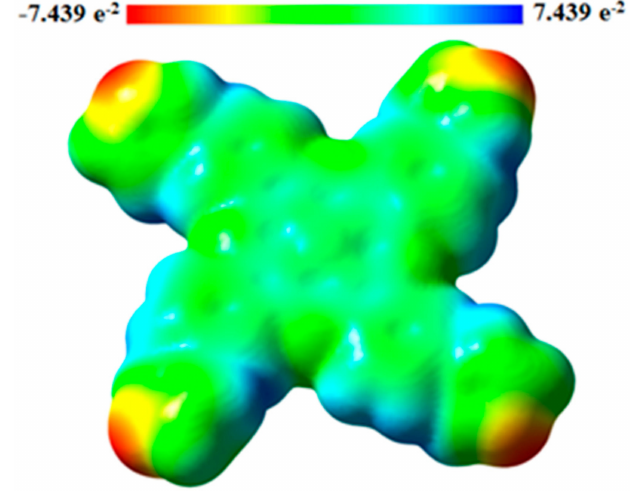
Figure 5. Molecular electrostatic potential (MES) surface for PdPc.